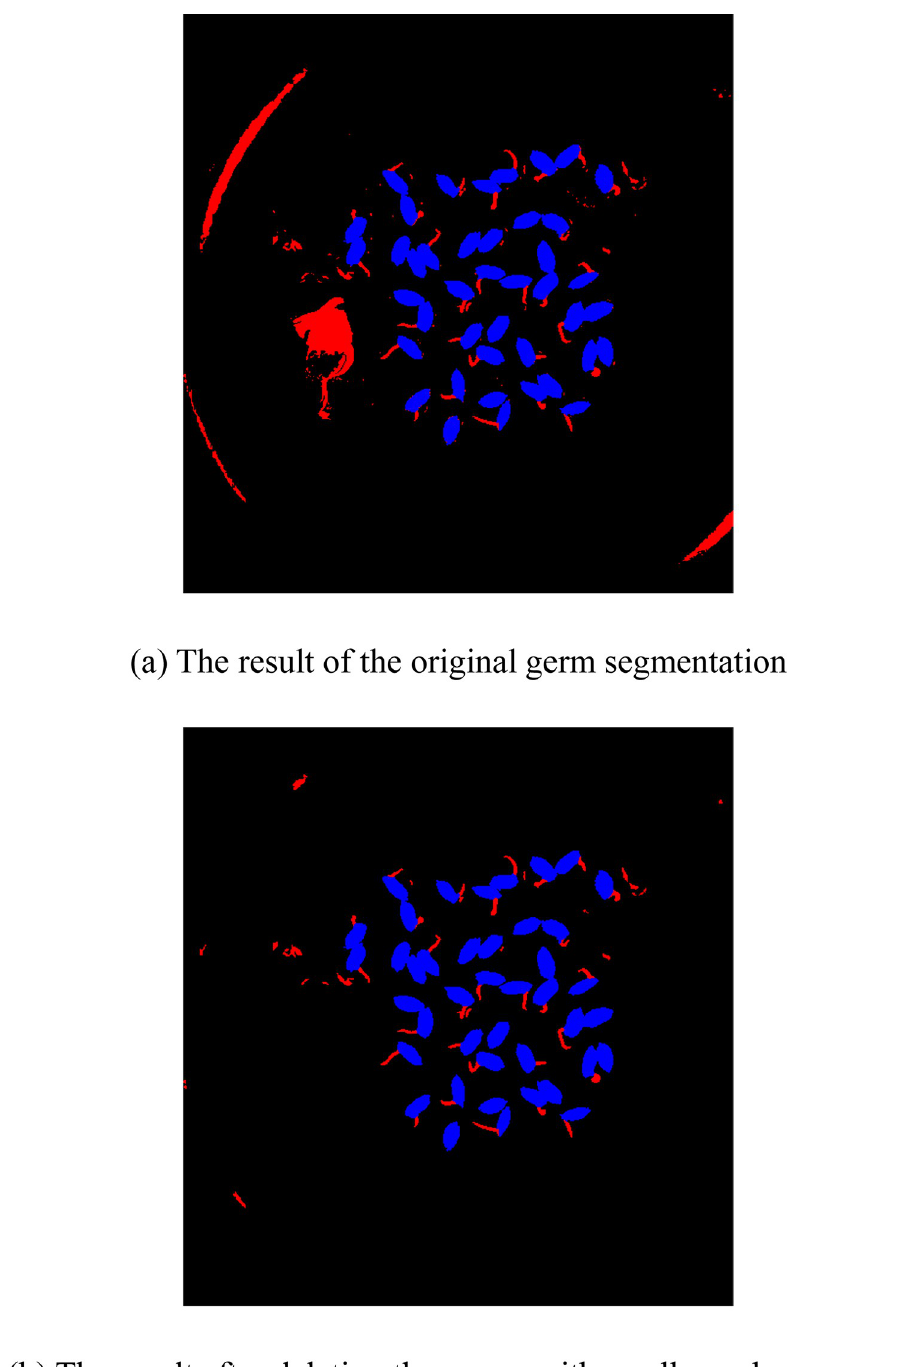
Fig 7. The result of germ